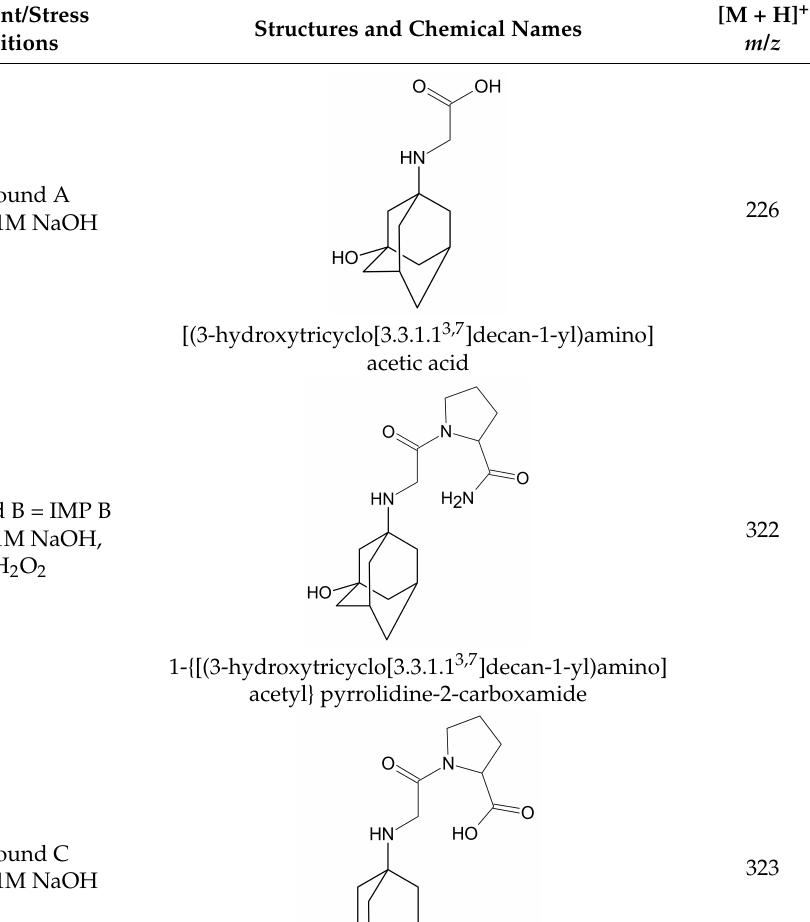
Table 4. Degradation products of vildagliptin detected by our UHPLC-DAD-MS